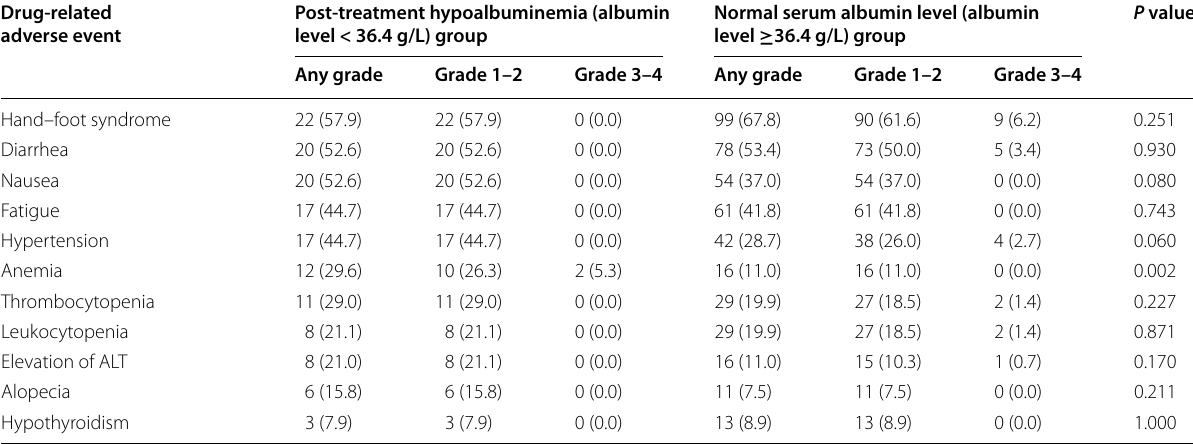
All data are presented as the number of patients followed by percentage in parentheses ALT, alanine aminotransferase * Grade 1–2 and grade 3–4 adverse events were combined in P value calculation